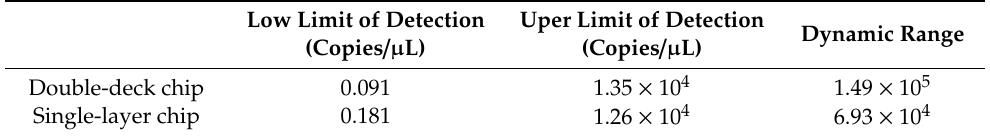
Table 1. Comparation of double-deck dPCR chip and single-layer dPCR chip in sensitivity and dynamic range of